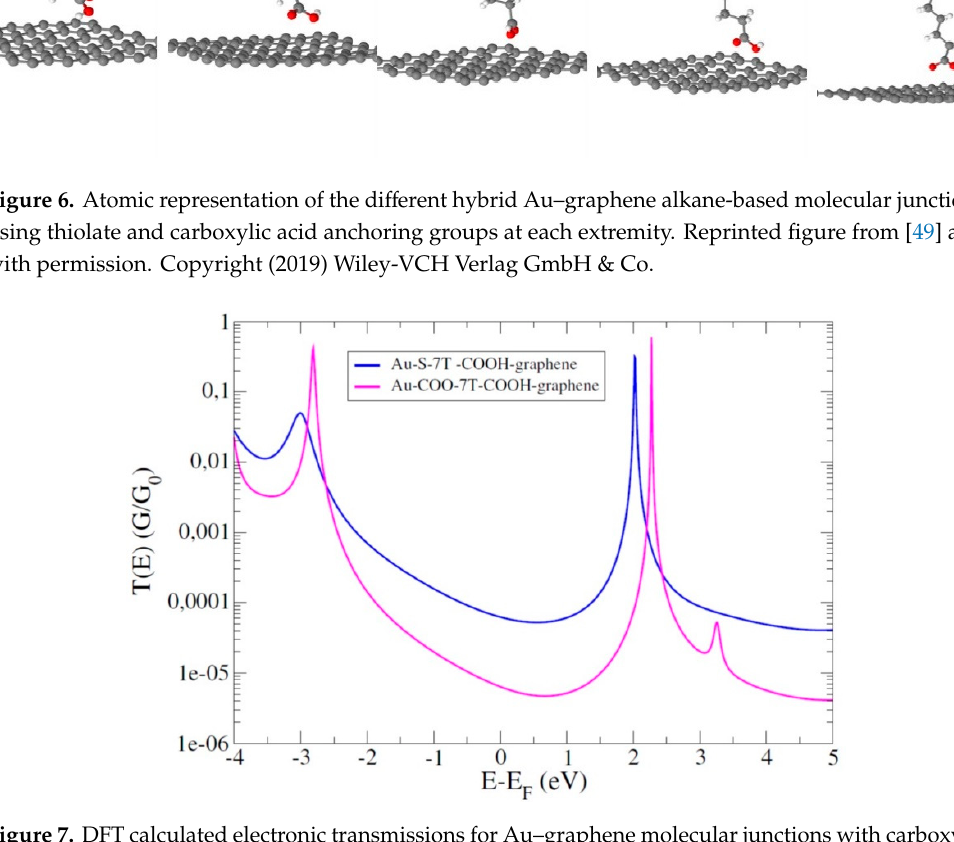
Figure 7. DFT calculated electronic transmissions for Au–graphene molecular junctions with carboxylic acid anchoring groups at each extremity (pink) and a thiol group at one extremity and a carboxylic acid at the other one (blue). Reprinted figure from [49] and with permission. Copyright (2019) Wiley-VCH Verlag GmbH & Co.